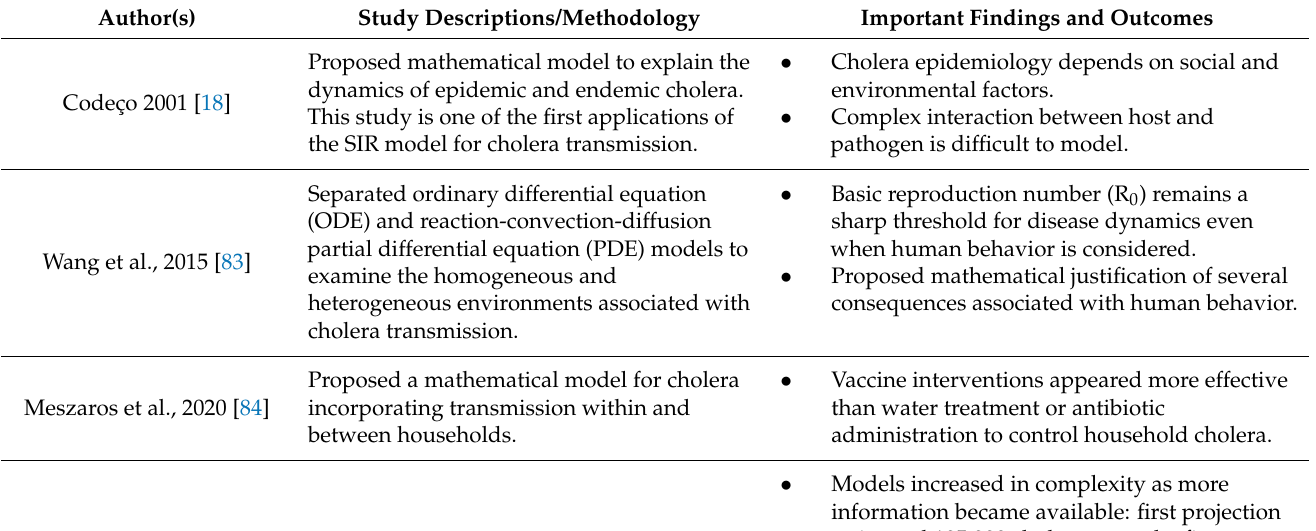
Table 1. Cholera prediction using variants of susceptible-infectious-recovered